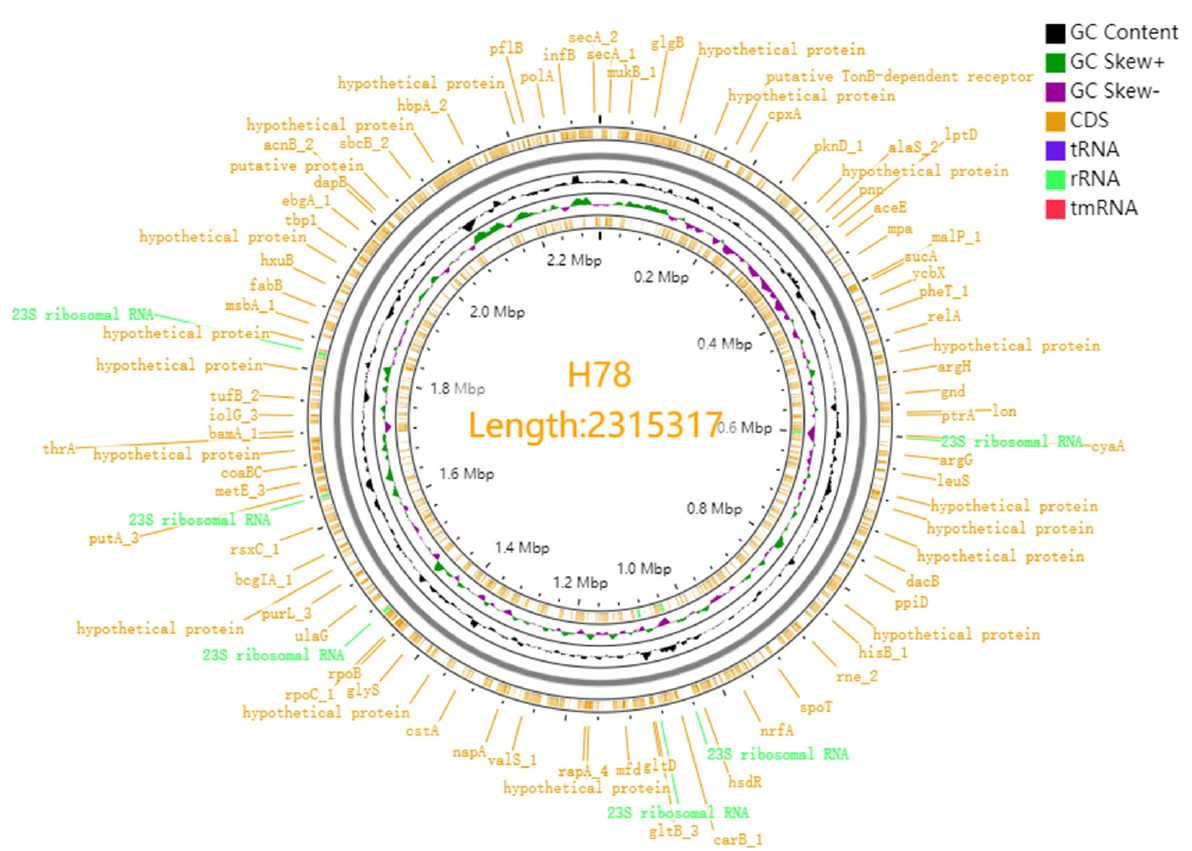
Figure 2. Genetic map of G. parasuis